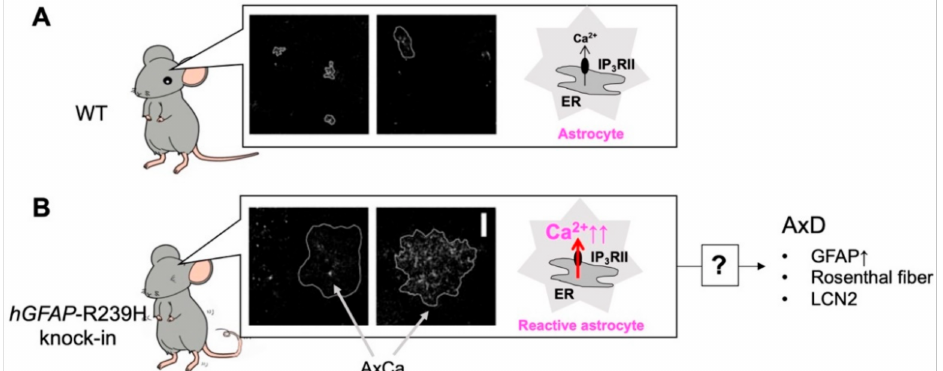
Figure 3. Abnormal Ca 2+ (AxCa) signals in reactive astrocytes cause Alexander disease (AxD). Unlike in WT mice ( A ), in hGFAP -R239H knock-in mice, hippocampal astrocytes are reactive and show abnormal extremely large Ca 2+ signals called “AxCa” signals ( B ). AxCa signals in AxD astrocytes are mediated by type II inositol 1,4,5-trisphosphate receptors (IP 3 RII) and are abolished in AxD-IP 3 RII knockout (KO) mice. Importantly, typical indicators of AxD such as an increase in glial fibrillary acidic protein (GFAP), the formation of Rosenthal fibers, and the induction of lipocalin 2 (LCN2) are dramatically decreased in AxD-IP 3 RIIKO mice. Although the mechanisms underlying AxCa signal-mediated AxD pathology remain largely unknown, AxCa signals in AxD astrocytes are a cause of